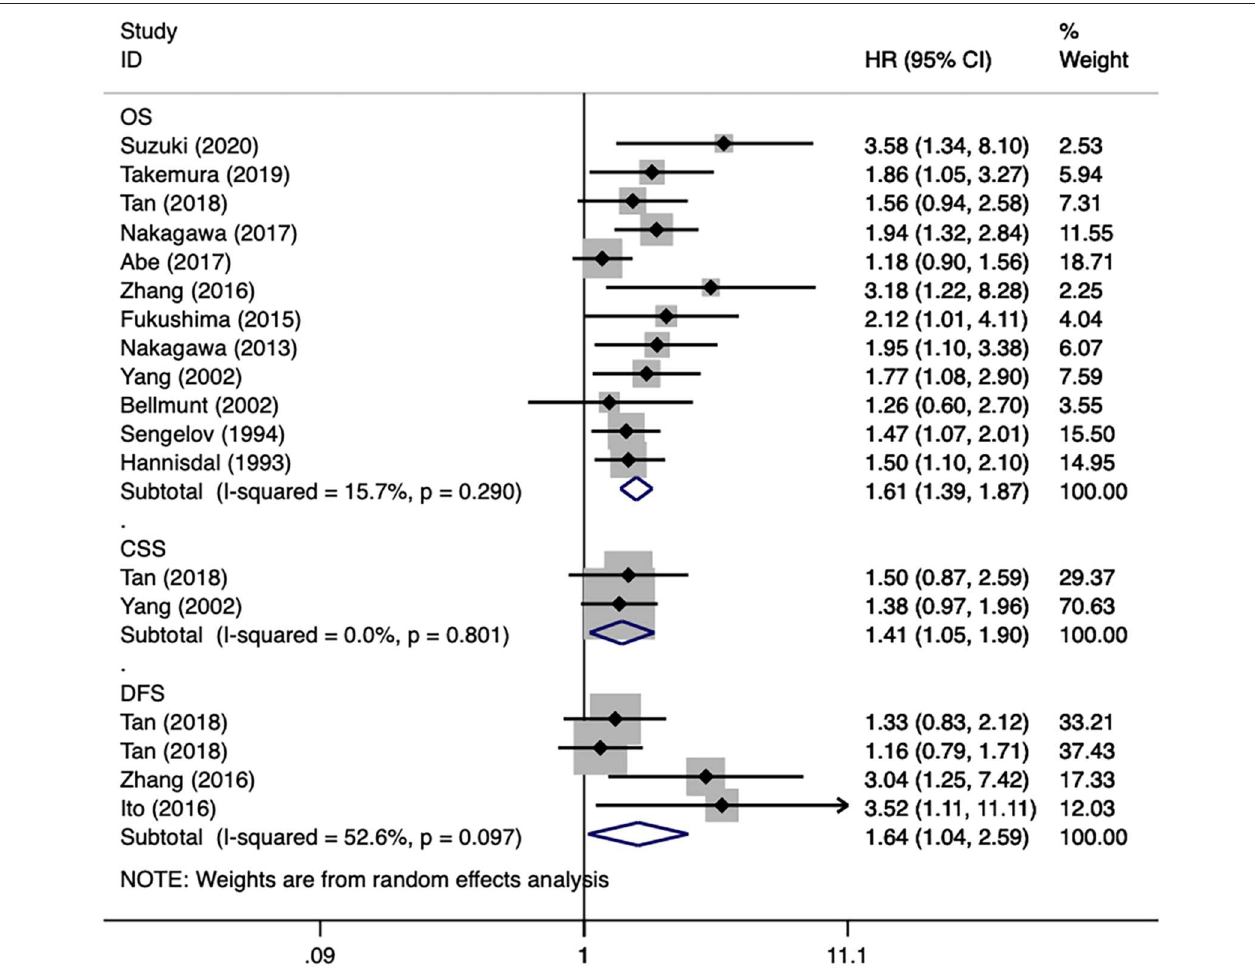
FIGURE 2 | Forest plots of studies about urothelial